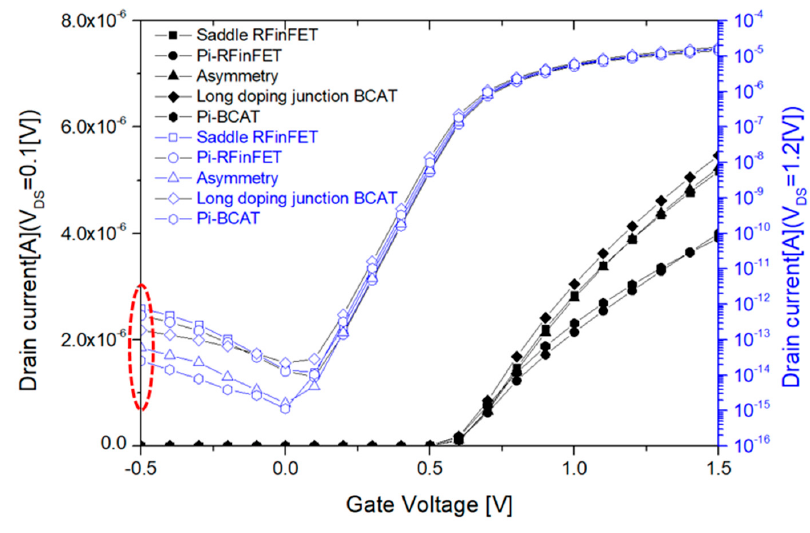
Figure 4. Linear (V DS = 0.1 V) and Log (V DS = 1.2 V) current graph of five structures.